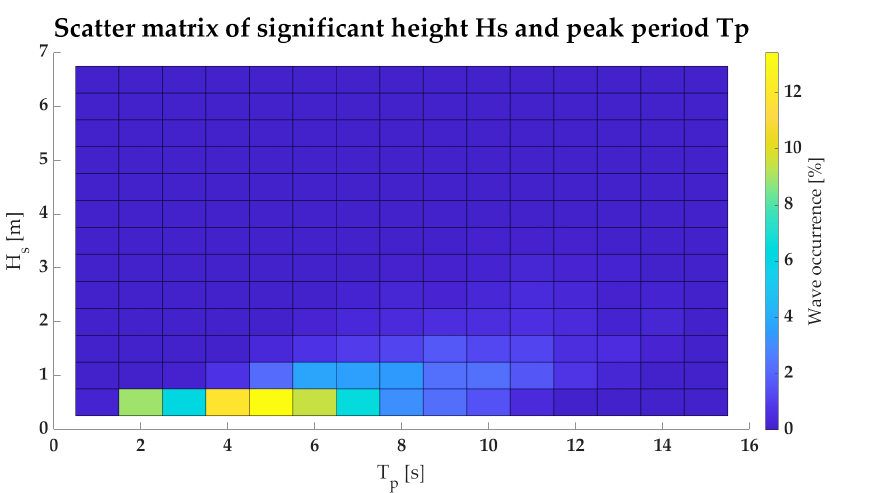
Figure 4. Scatter matrix of significant height, Hs [m], and peak period, Tp [s], for the case study. Based on data available from